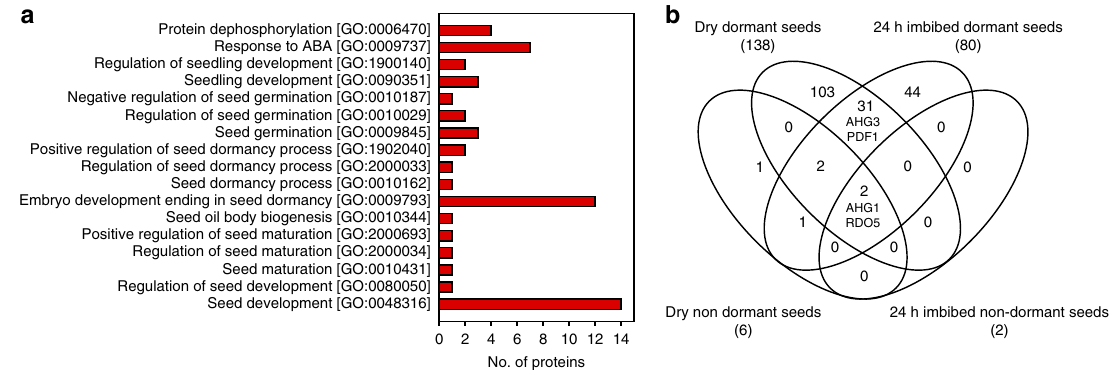
Fig. 2 Overview of proteins that were pulled-down with DOG1 from seeds. a Number of YFP-DOG1 interacting proteins that are annotated with GO_biological processes related to seeds, response to ABA, and protein dephosphorylation (for clarity only GO categories with matches are shown). b Venn diagram showing the distribution among the different tested conditions of the 184 proteins that were identi fi ed exclusively in the YFP-DOG1 pull- down. Numbers below each condition indicate the total number of